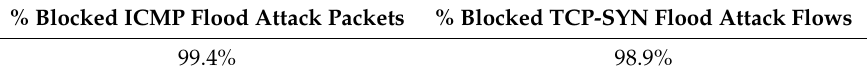
Figure 12. Normal traffic volume arriving at the victim: ( a ) TCP-SYN (flows/s); and ( b ) ICMP (packets/s). Table 9. Efficiently Mitigate TCP-SYN Flood and ICMP Flood